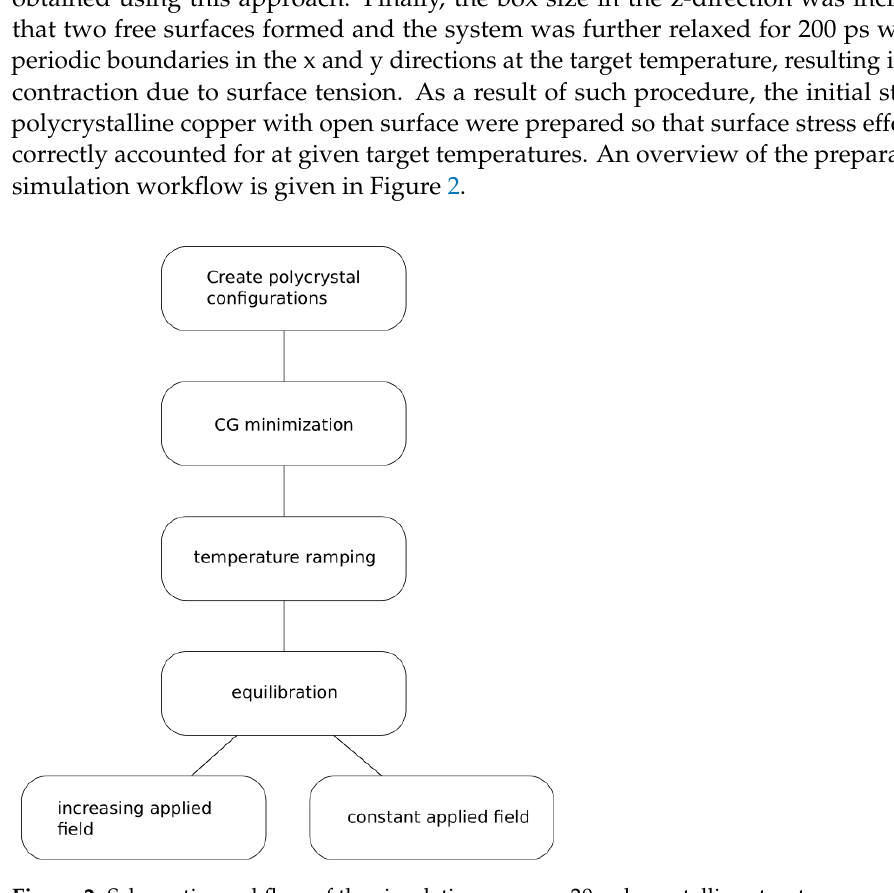
Figure 2. Schematic workflow of the simulation process. 20 polycrystalline structures were obtained after the preparation process. Increasing applied field simulations were conducted for each structure at 7 different temperatures. Constant applied field simulations were conducted for a specific structure at 900 K for 10 fractional values of the critical stress. Each of those were repeated twice to obtain adequate statistics.